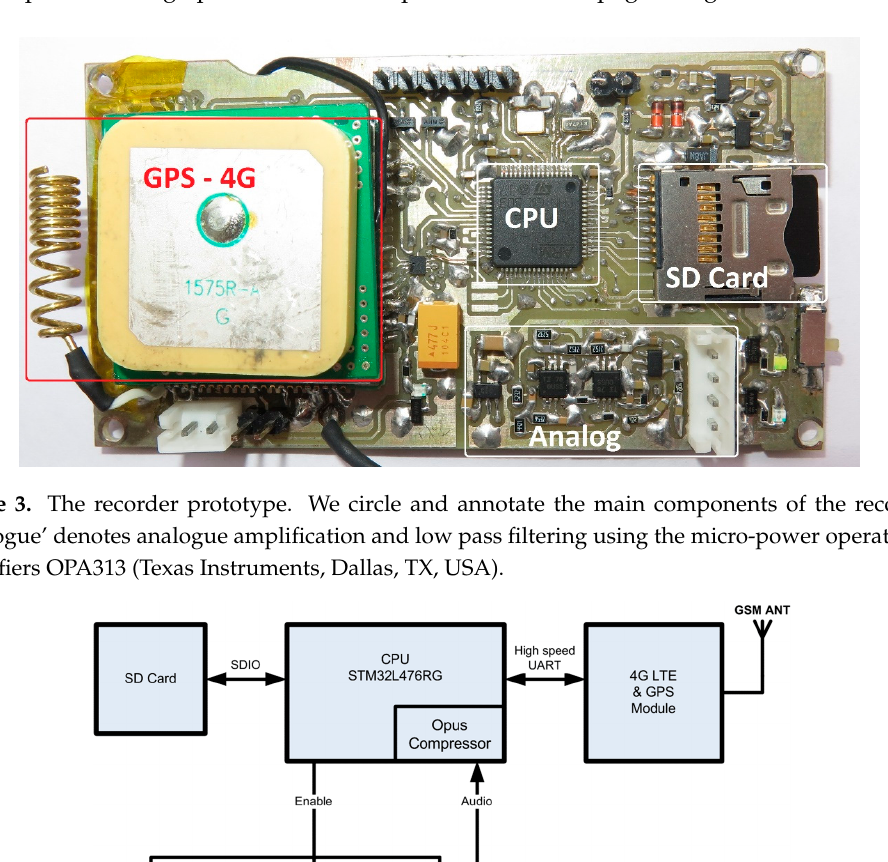
4 of 14 Figure 2. ( left ) The vibrations recorder: a rugged container for outdoor deployment contains the electronics including GPS and GPRS, ( right ). Detail of the metal waveguide fastened to the input of the accelerometer. The tree trunk is first drilled using a bit matching the size of the probe and the waveguide is subsequently inserted and fastened in the hole. Drill bits can be conveniently adjusted to a drill bit adapter that, in turn, is fastened onto the accelerometer. Different waveguides apply to different user scenarios e.g., wooden columns, decks, porch tongues, ceilings, roots of plants. The waveguide is attached to an 805 Μ 1-0020 accelerometer (TE Connectivity Ltd, Rheinstrasse 20 Ch-8200 Schaffhausen, Switzerland), that is based on a stable piezo-ceramic crystal with low power electronics. We chose this accelerometer mainly for its frequency response (i.e., 1–8 kHz) where feeding impulsive sounds lie [8,16] and its sensitivity at 100 mV/g. However, besides these two criteria, we have not optimized the accelerometer selection and other choices may be applicable. The